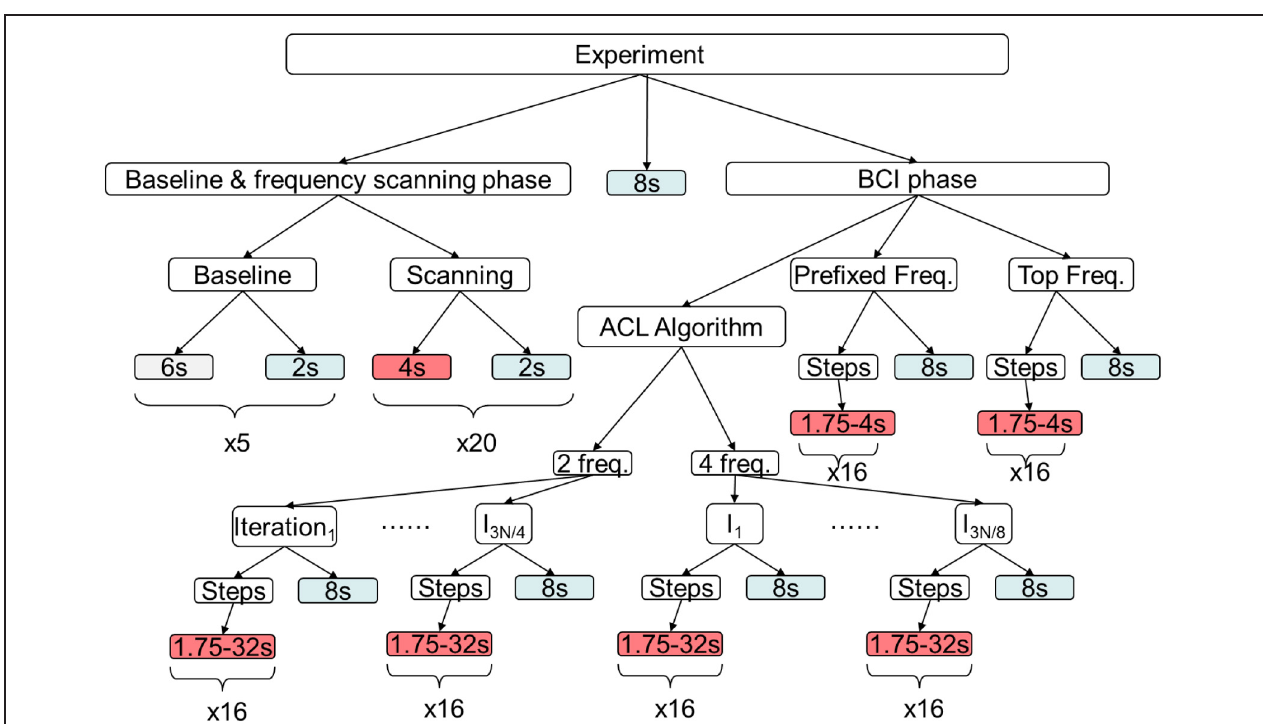
FIGURE 3 | Timeline of the experiment. In the first phase individual EEG baseline activity is measured and in the following frequency scanning phase those frequencies electing largest SSVEP magnitudes are selected for each subject individually, while those below a predefined threshold are excluded